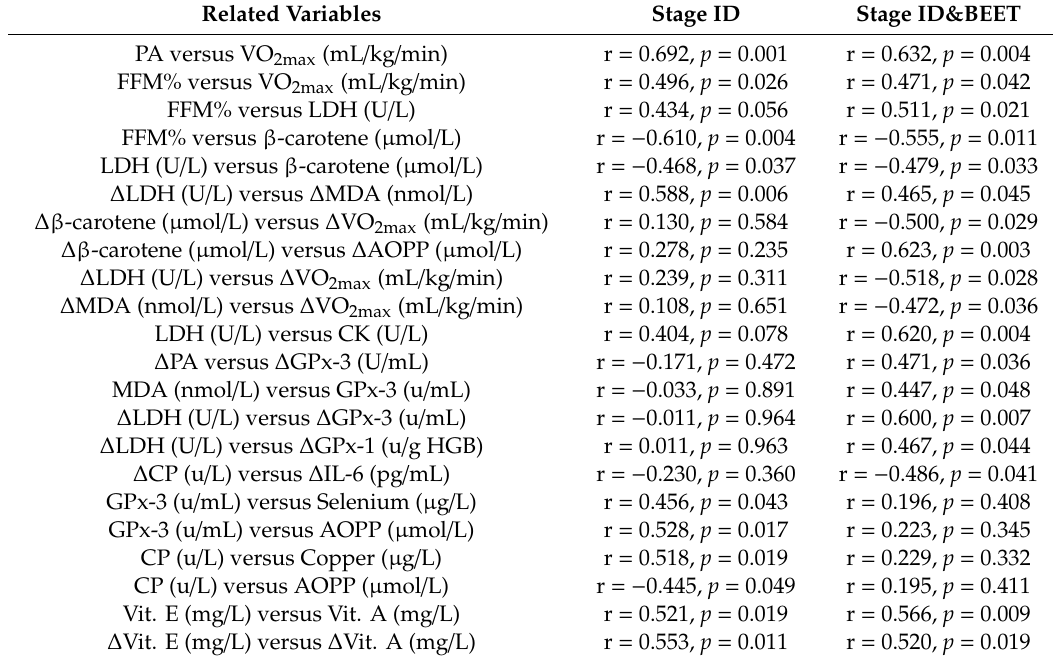
Table 4. Correlations between anthropometric parameters, physical activity level, values of maximum rate of oxygen uptake, and serum concentrations of measured parameters after consecutive